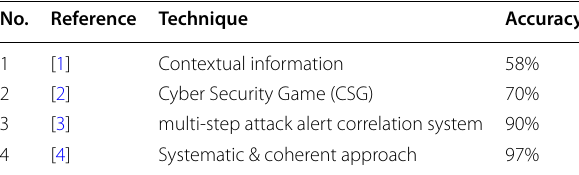
Table 1 Summary of existing